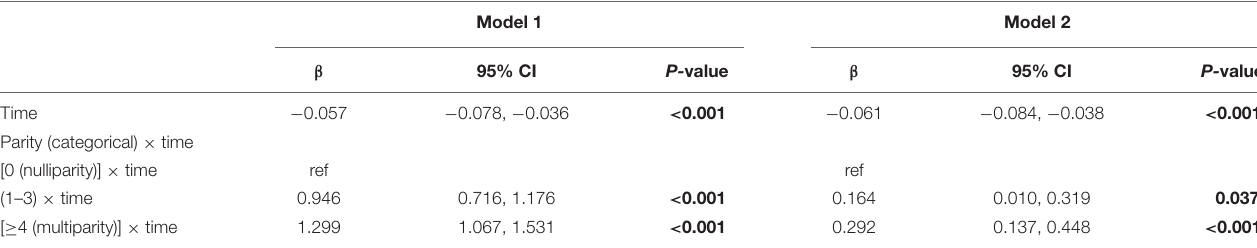
TABLE 3 | Estimated mean change in 3MSE score ( β coefficients) and 95% confidence intervals by parity groups over the follow-up